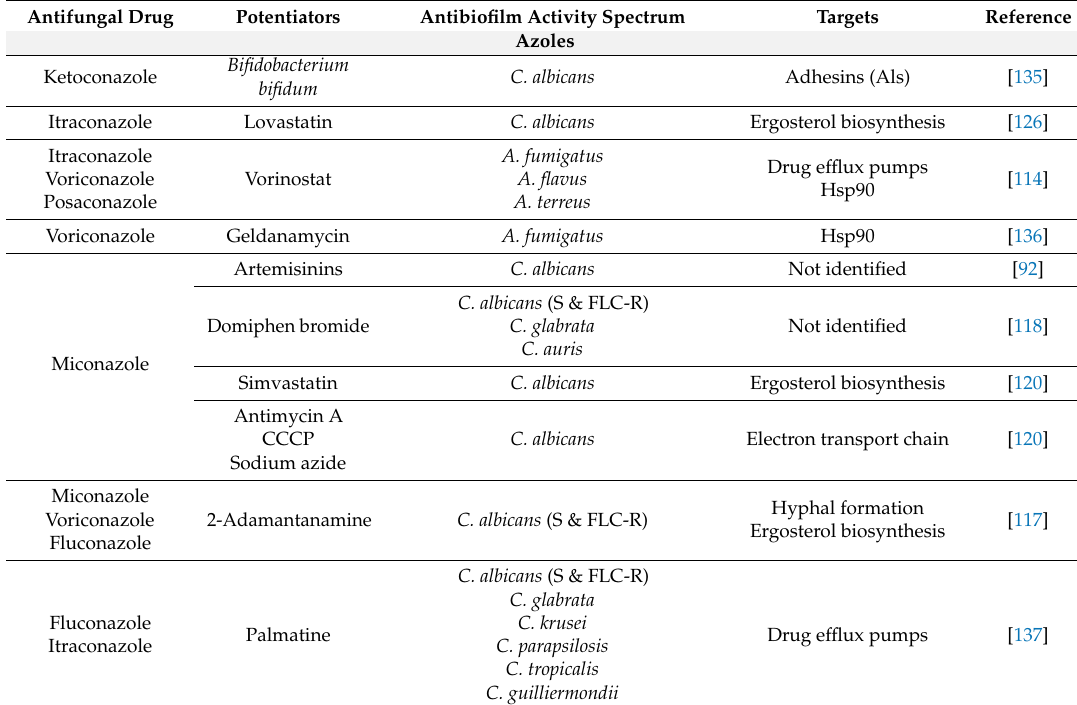
Table 1. Overview of antibiofilm combinations, classified according to the antifungal drug class, with their antibiofilm activity spectrum and mode of action 1